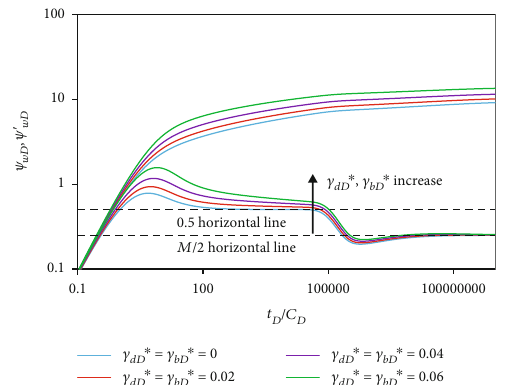
Figure 9: Well test curves of the pressure buildup well test under di ff erent stress sensitivity coe ffi cients.